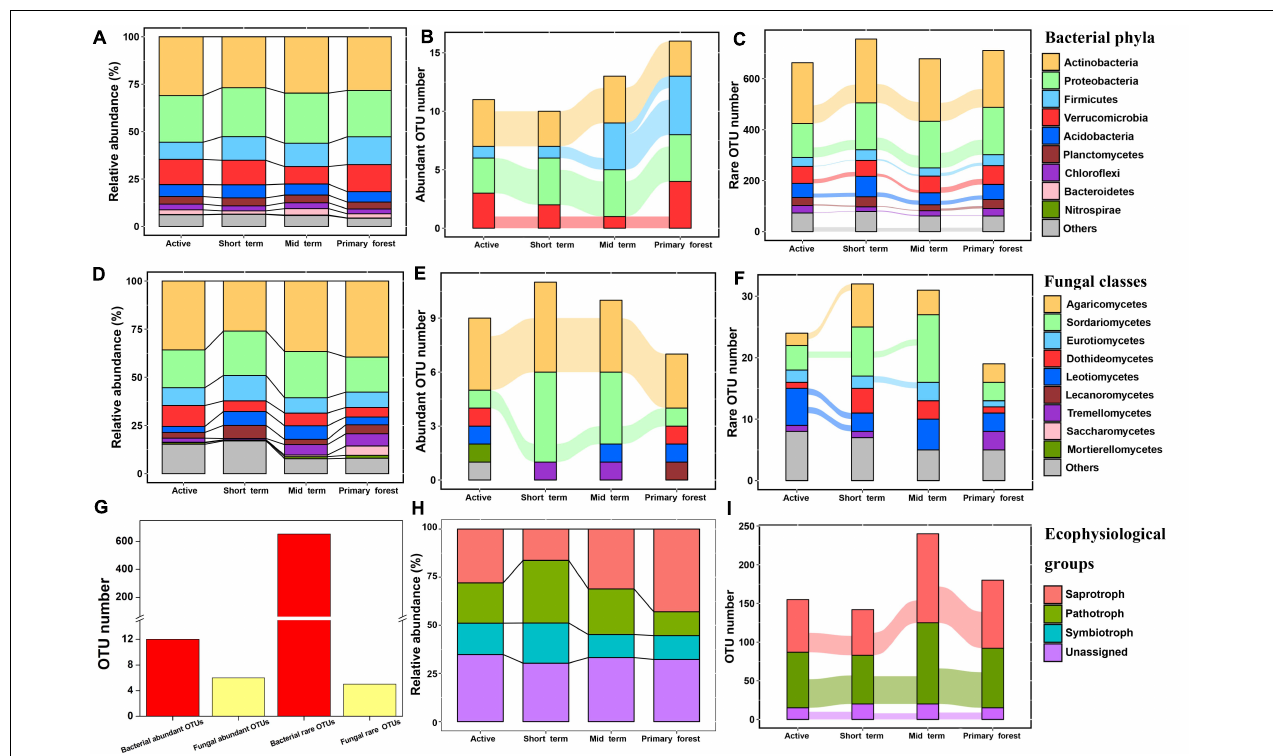
FIGURE 3 | The composition of bacterial communities at the phylum level (A) , of fungal communities at the class level (D) , and of fungal ecophysiological groups (H) in four successional stages at swidden agricultural sites in lowland forests. For abundant OTUs, rare OTUs or fungal ecophysiological OTUs that were present in at least half of the samples in each of two adjacent successional stages, the lines connecting the stages indicated the transfer of those OTUs to the next successional stage: abundant bacterial OTUs (B) ; abundant fungal OTUs (E) ; present fungal ecophysiological OTUs (I) ; rare bacterial OTUs (C) ; rare fungal OTUs (F) ; total number of bacterial and fungal abundant/rare OTUs across at least two stages (G) . The lines represented the “transfer” of OTUs between stages, and the width of the line indicated the number of OTUs